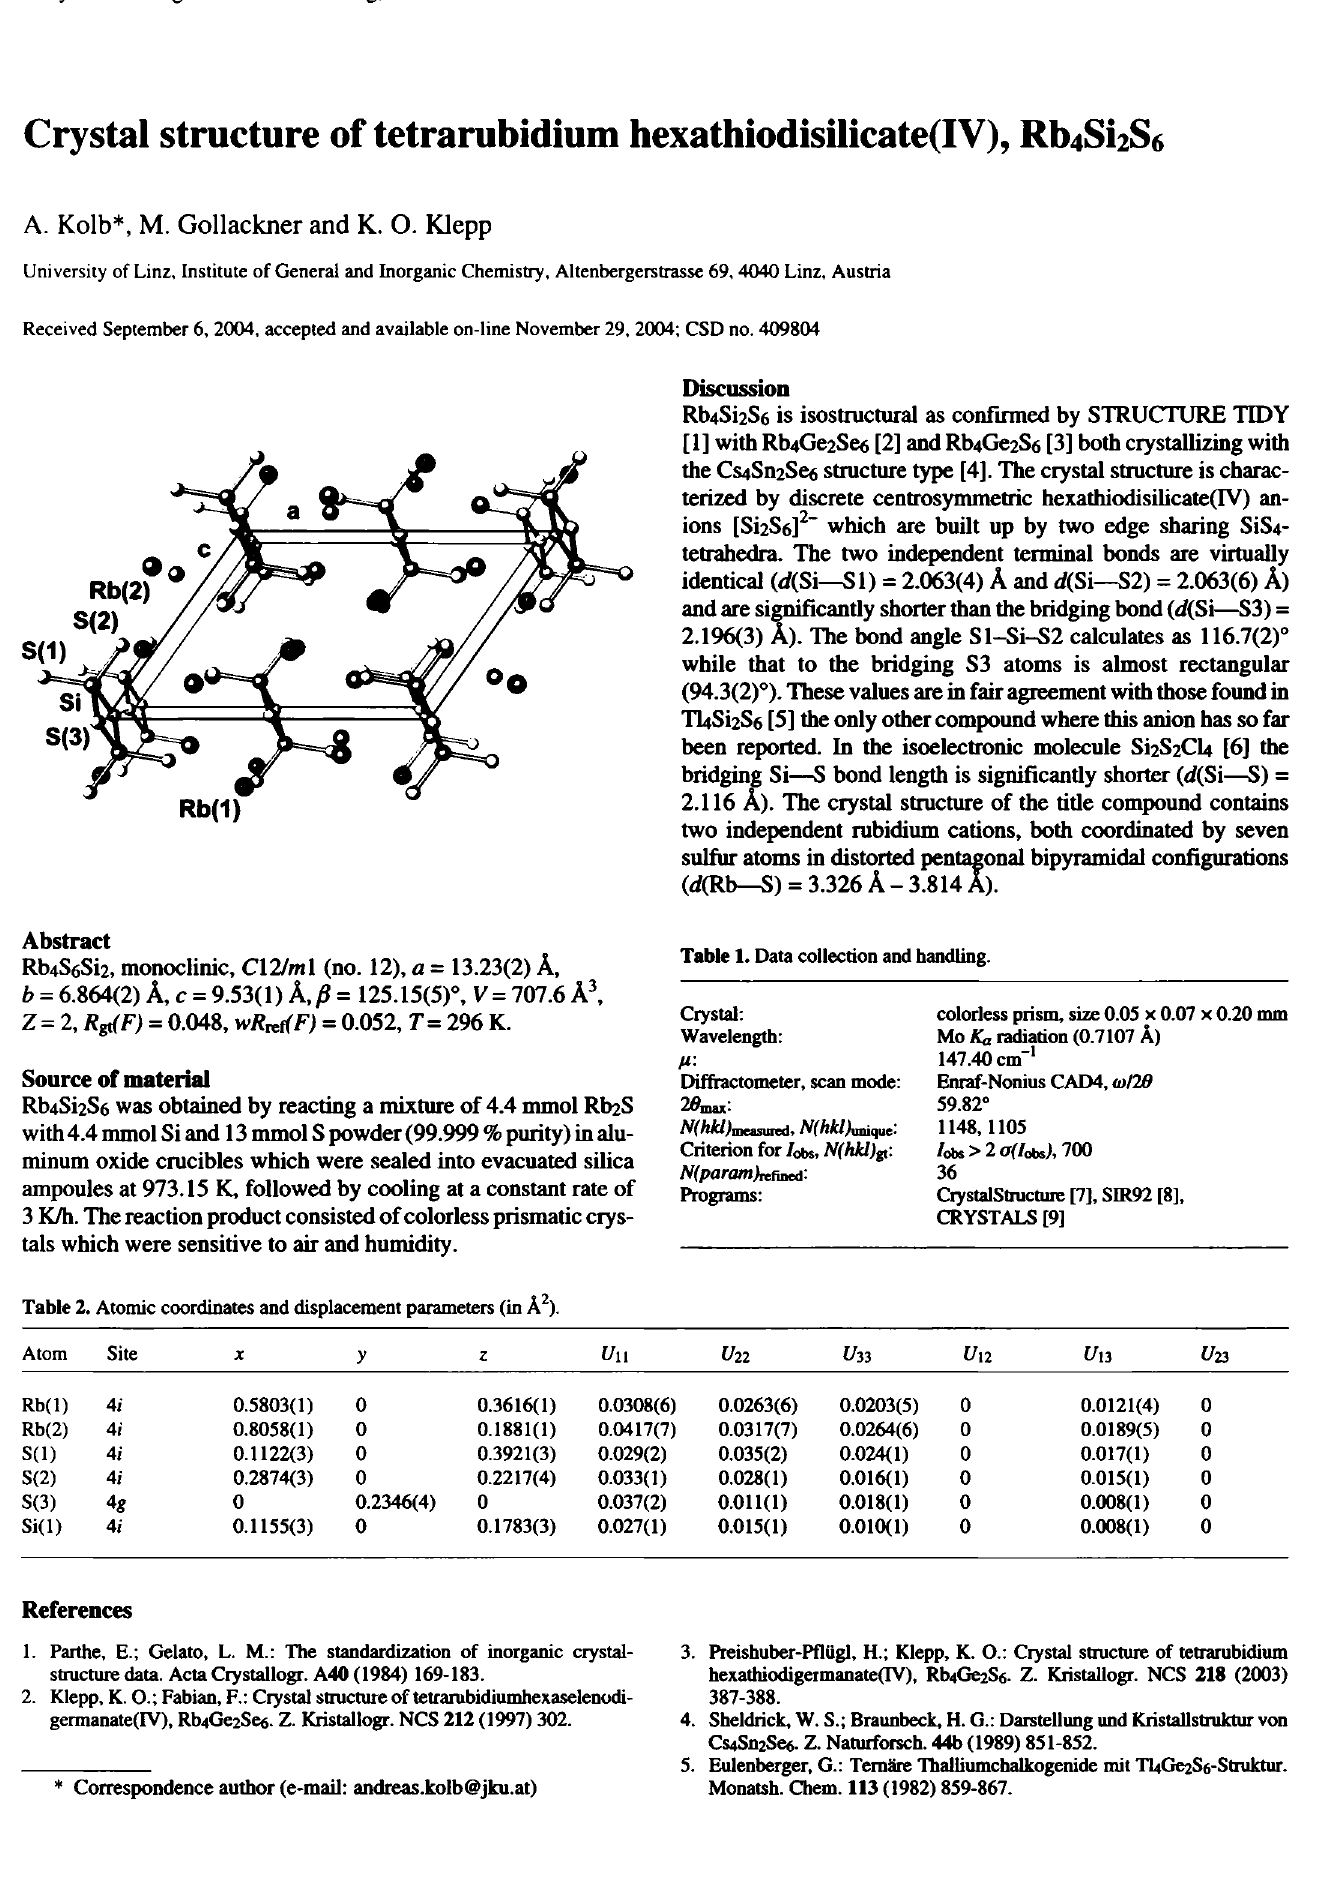
Table 2. Atomic coordinates and displacement parameters (in Â 2